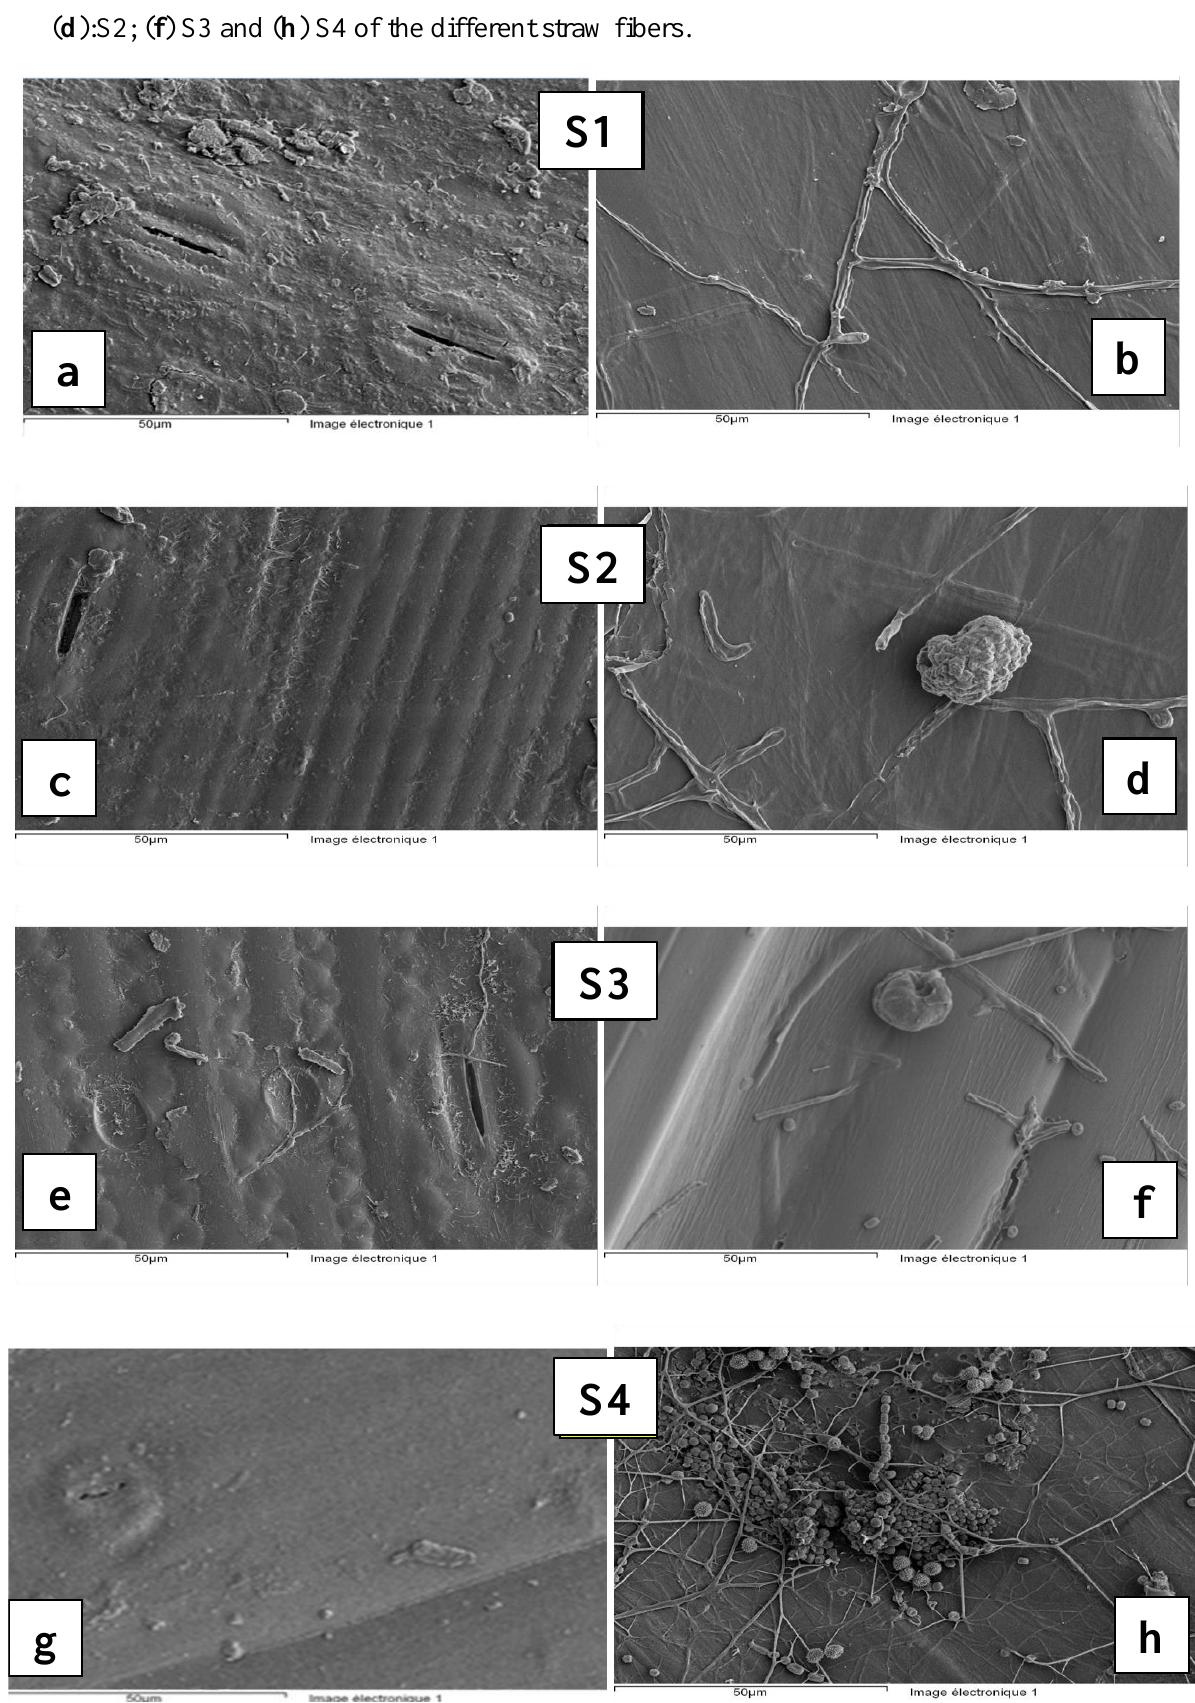
Figure 2. Outside surfaces ( a ) S1; ( c ) S2; ( e) S3 and ( g ) S4 and inside surfaces ( b ) S1; ( d ):S2; ( f ) S3 and ( h ) S4 of the different straw